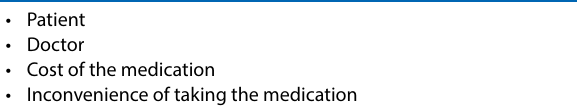
Table I: The driving forces behind stopping